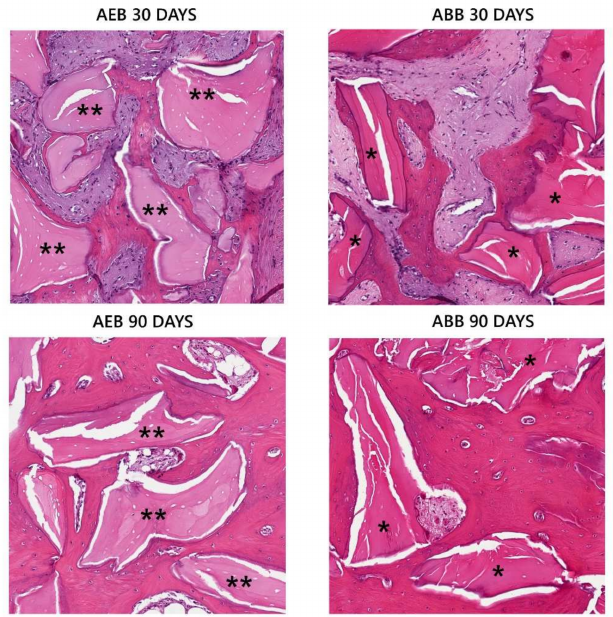
Figure 6. Histological examination of grafted particles at 30 and 90 days from regenerative procedure. At 30 days AEB (**) and ABB (*) particles were surrounded by a thin layer of newly formed bone. At 90 days AEB (**) and ABB (*) particles appeared integrated in extended bony islands.